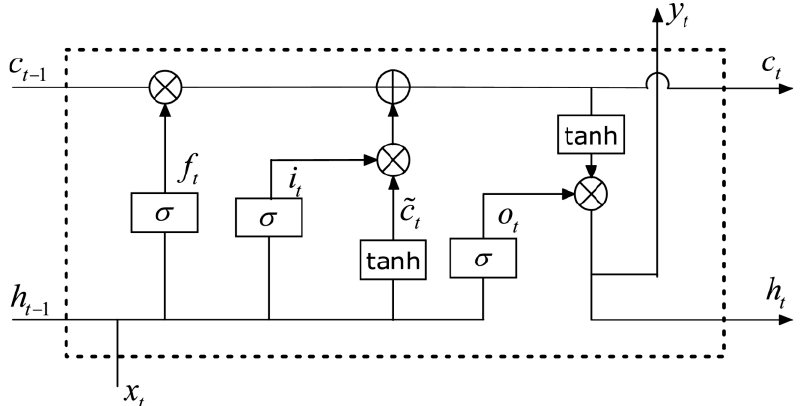
Figure 15. The LSTM cell structure diagram. Reprinted with permission from Ref. [109]. Copyright year 2021, copyright owner IEEE.